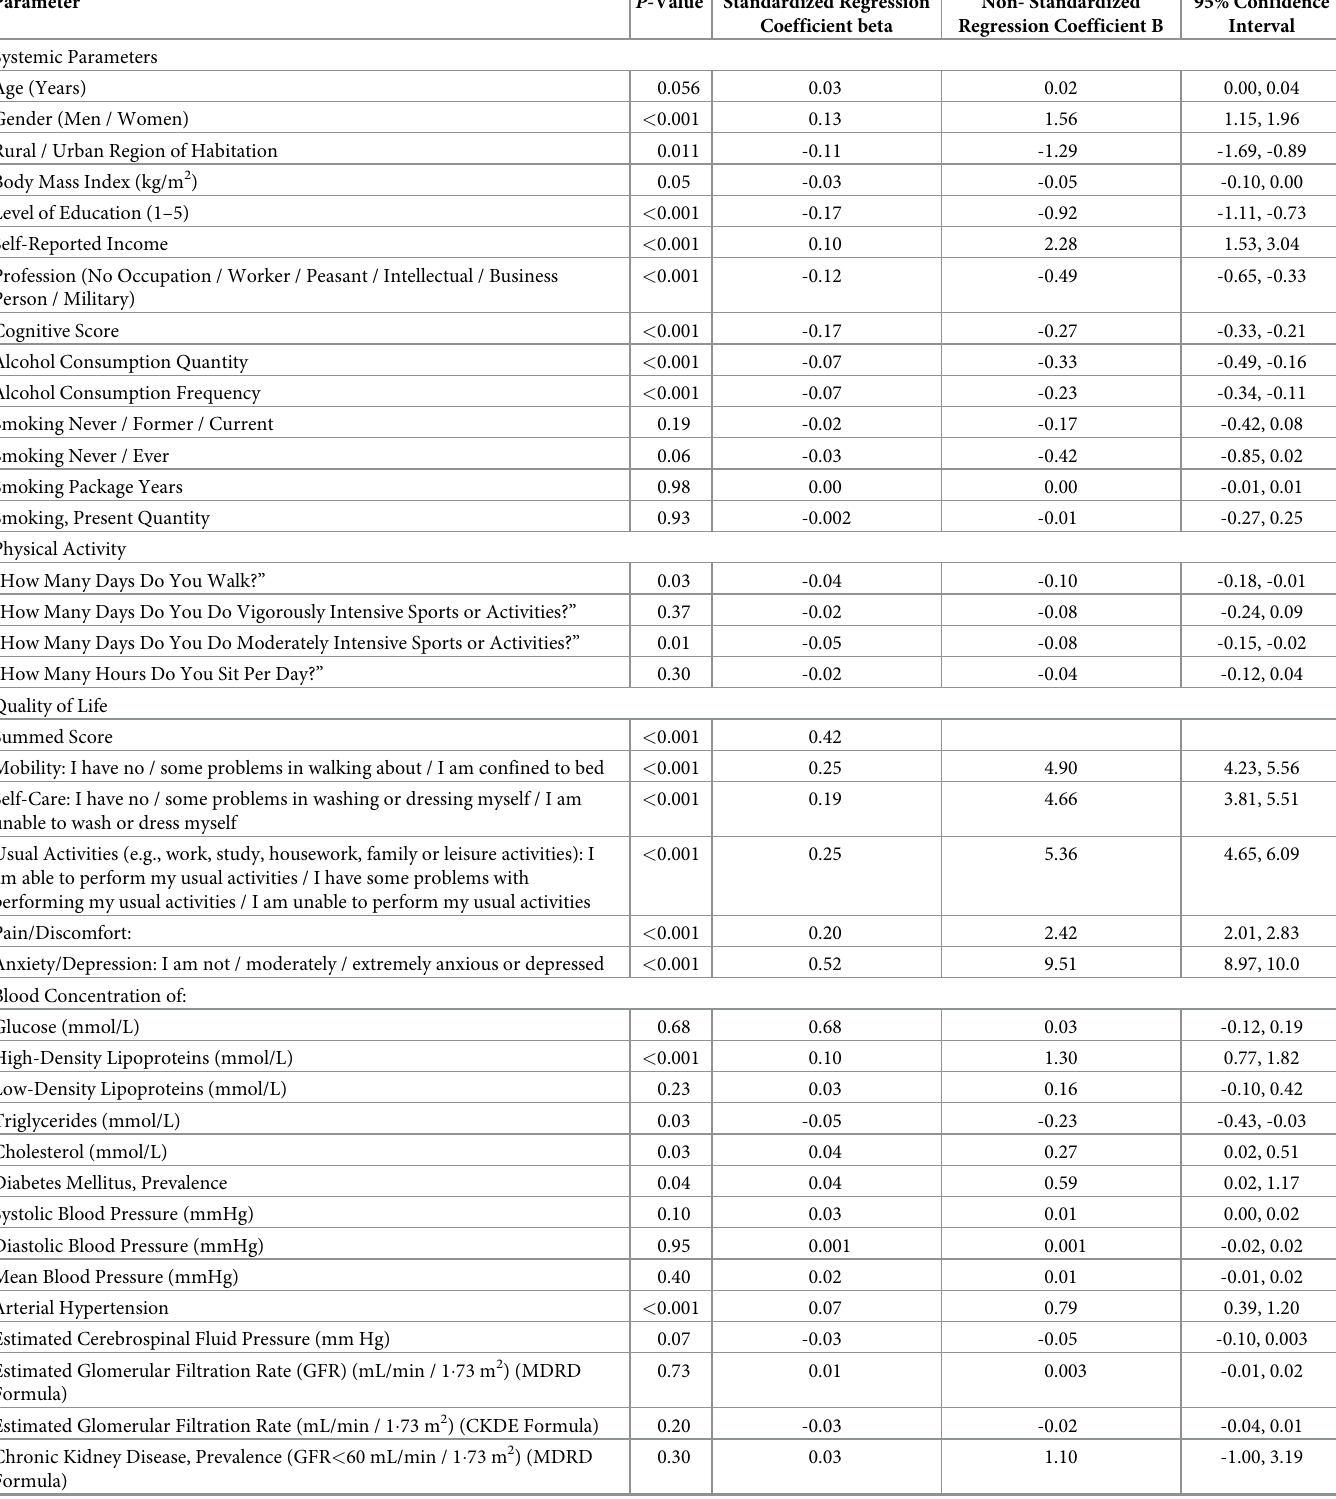
Table 1. Univariate associations between self-rated depression scores and systemic and ocular parameters in the Beijing Eye Study.